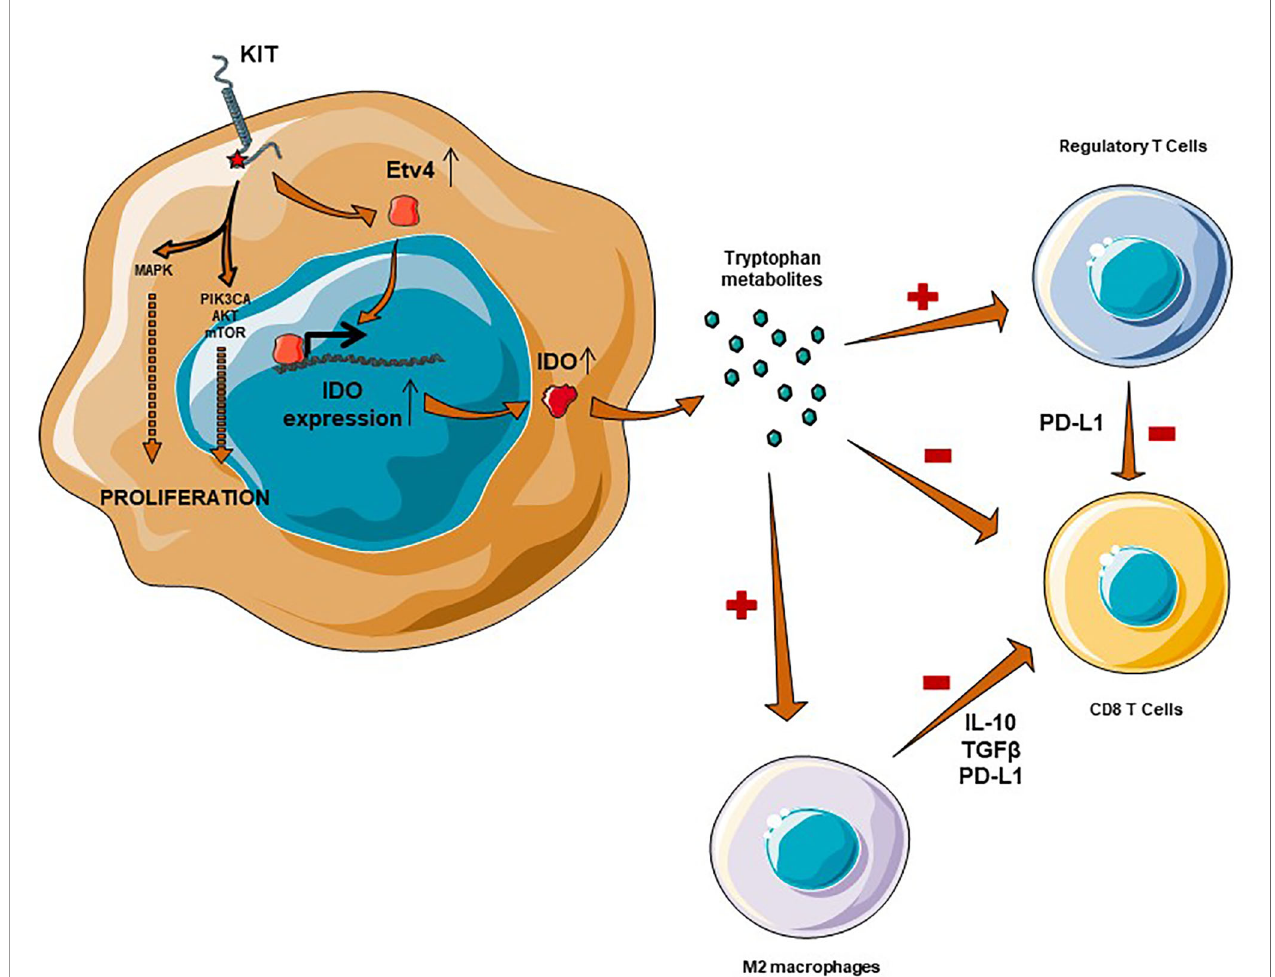
FIGURE 1 | Immunosuppressive microenvironment in GIST is mediated by IDO and M2 macrophages. IDO expression is mediated through Etv4 and KIT activation, which results in an overexpression of IDO. IDO is responsible for a recruitment of regulatory T cells, an inhibition of CD8+ T Cells complementary to a macrophage